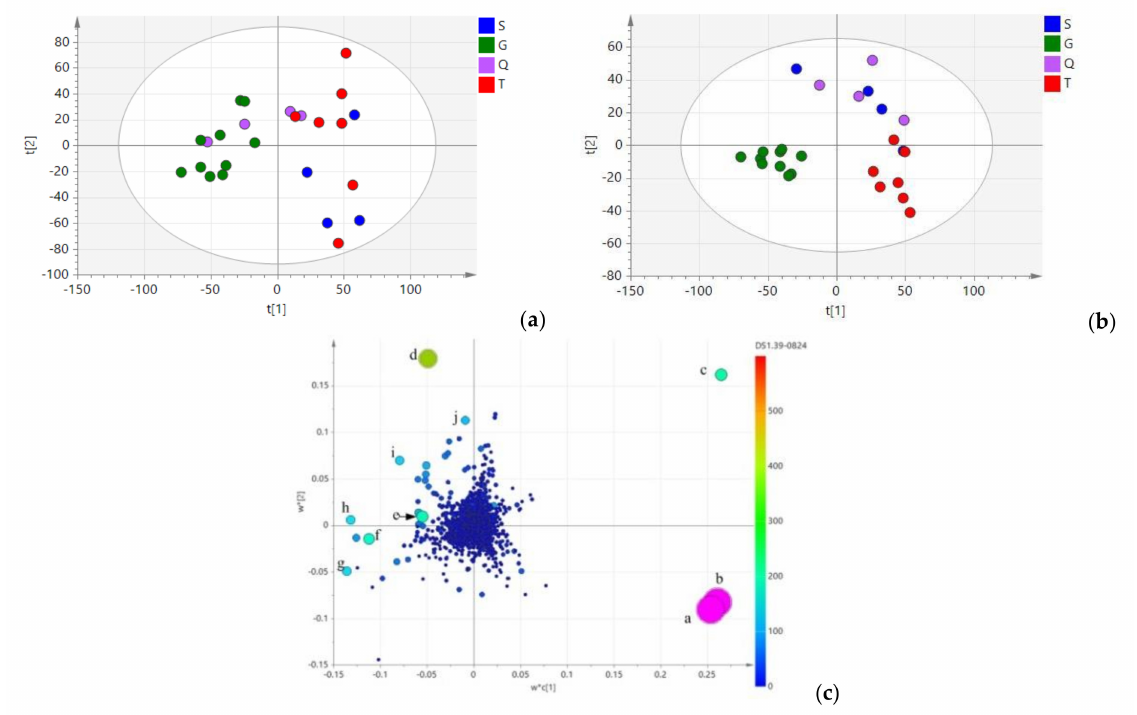
Figure 5. ( a ): Principal component analysis (PCA) score plot of L. rotata in four geographical origins. ( b ): Partial least-squares discriminant analysis (PLS-DA) score plot of L. rotata in four geographical origins. ( c ): Loading plot of PLS-DA analysis of L. rotata . a: forsythoside B ( t R 24.04 min, m / z